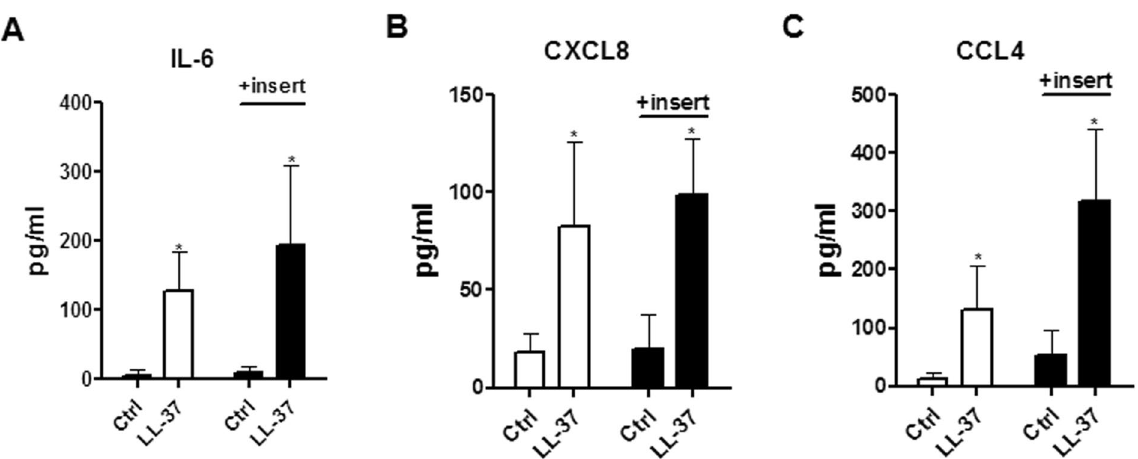
Figure 5. Effects of transwell inserts on cytokine/chemokine expressions in co-culture of eosinophils and BEAS-2B cells upon the stimulation of LL-37. Human eosinophils (3 × 10 5 ) and BEAS-2B cells (1 × 10 5 ) were cultured together with or without 10 µ g/ml LL-37 in the presence or absence of transwell inserts for 20 h. Release of IL-6 ( A ), CXCL8 ( B ) and CCL4 ( C ) in culture supernatant was determined. Results are shown as arithmetic mean plus SD of triplicate independent experiments. ** P < 0.01 when compared between the denoted group and the corresponding control groups without